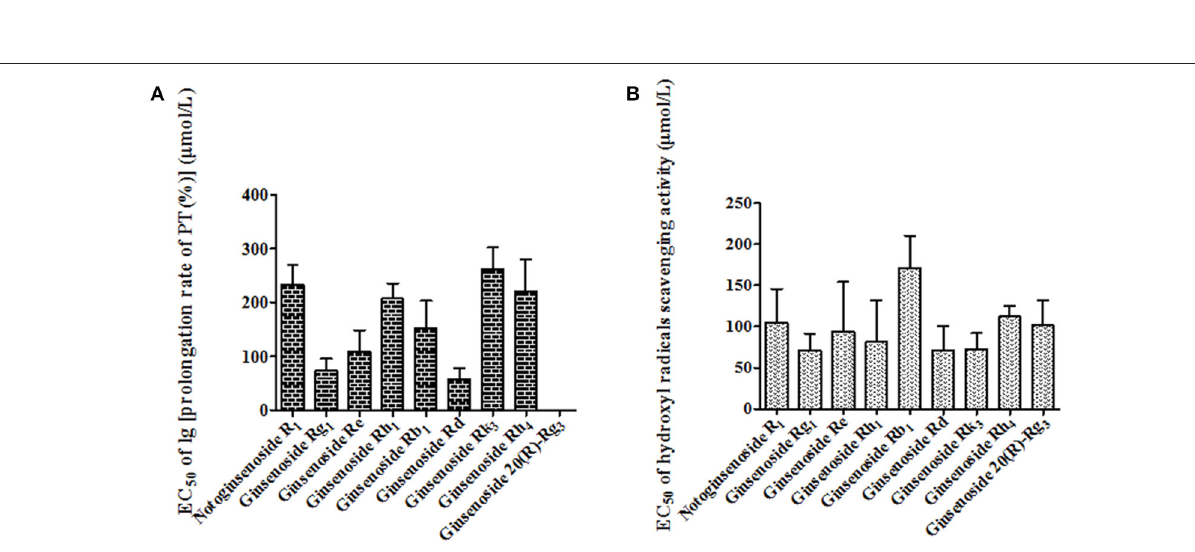
Frontiers in Pharmacology | www.frontiersin.org